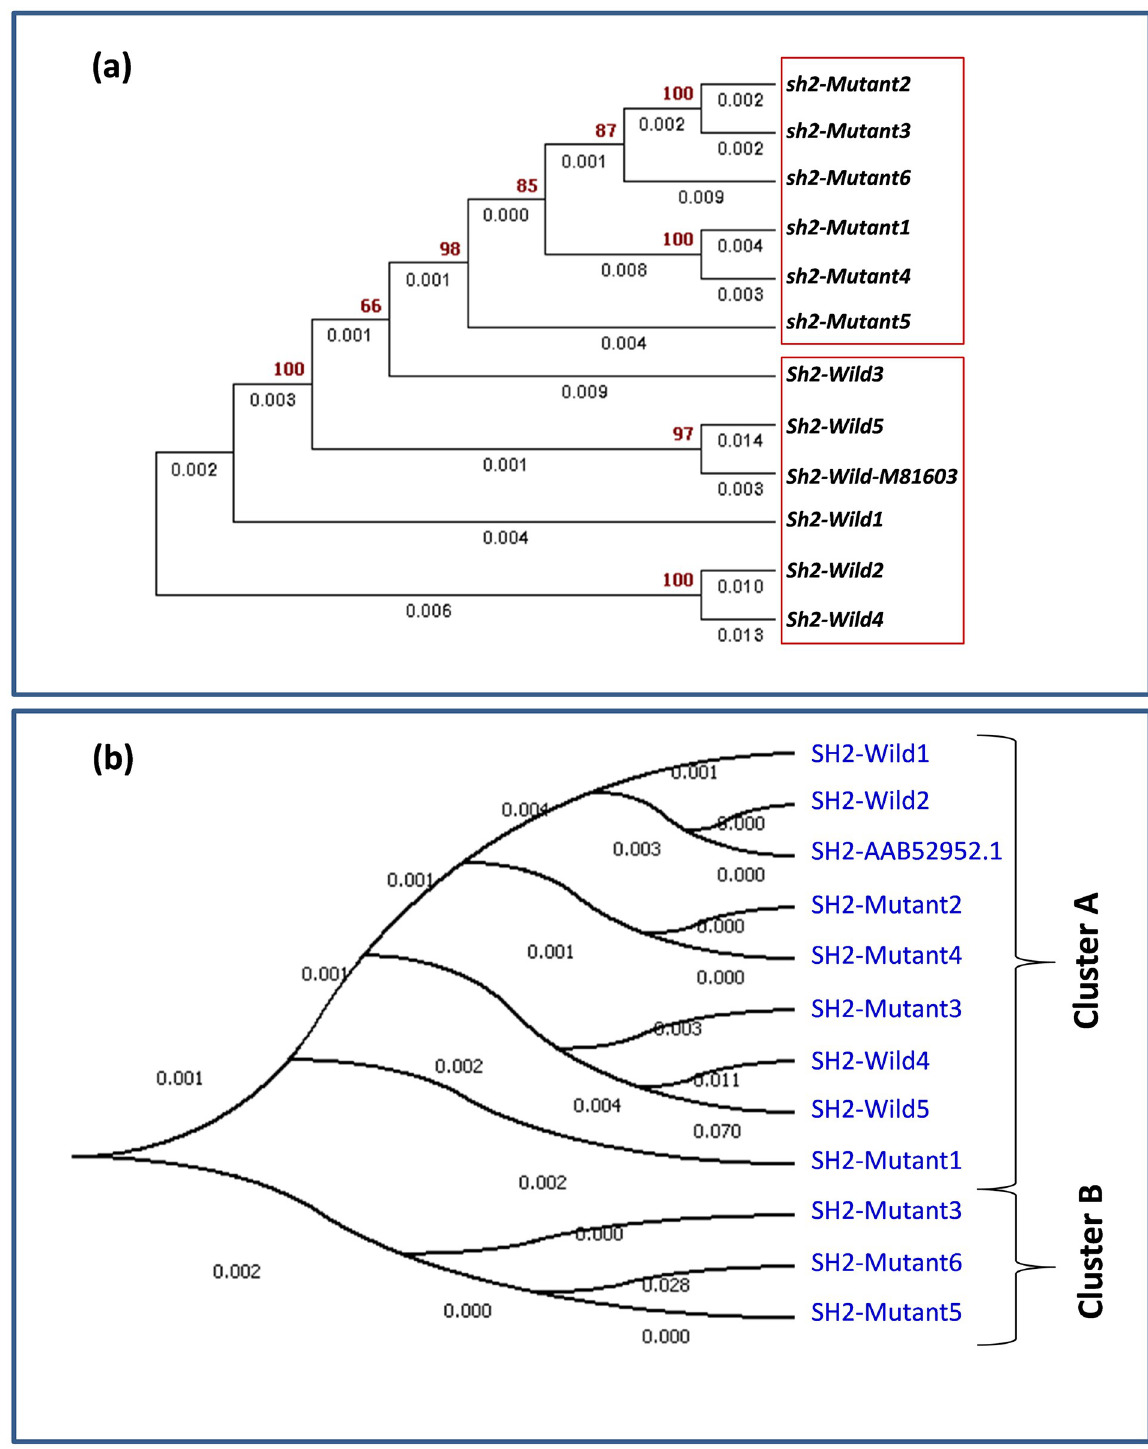
Fig 2. Phylogenetic analysis of selected sh2- mutants and wild inbreds on the basis of (a) nucleotide sequences and (b) protein sequences.